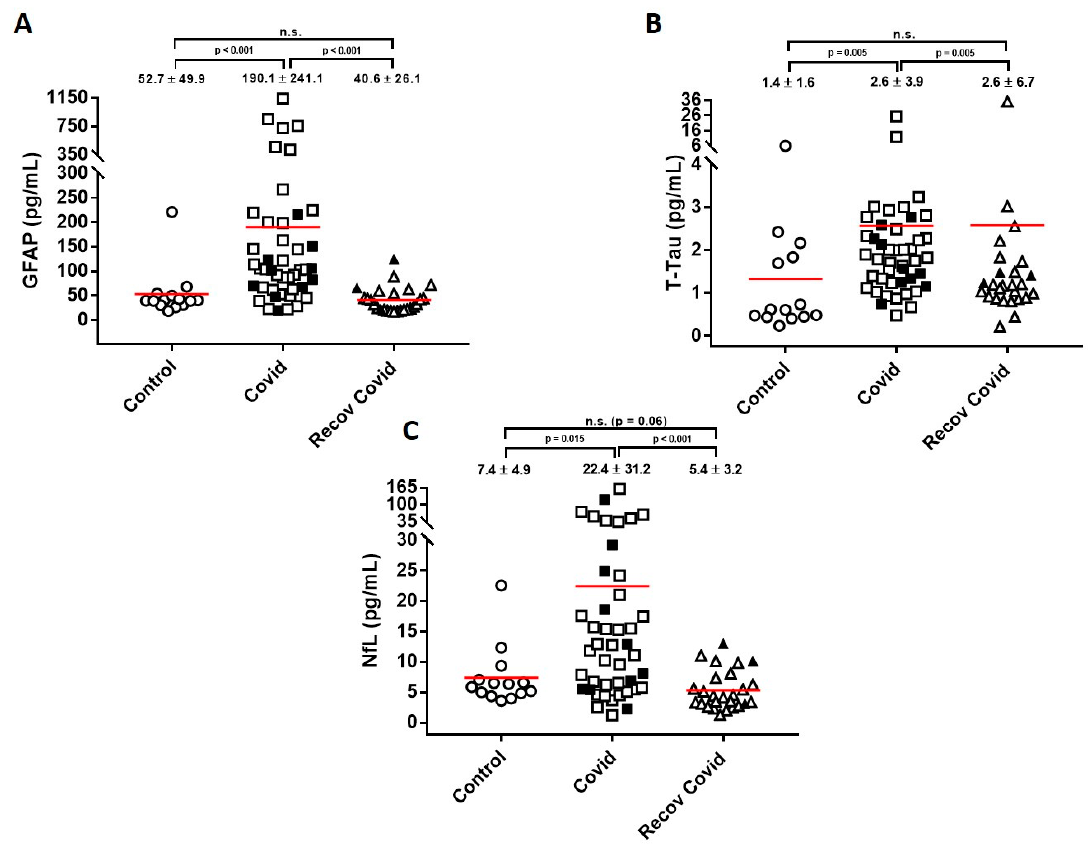
Figure 1. Quantification of astrocytic and neuronal injury biomarkers in COVID-19 patients. The absolute values obtained in plasma for ( A ) glial fibrillary acidic protein (GFAP), ( B ) total tau (T-tau) and ( C ) neurofilament light (NfL) from controls, COVID-19 patients at acute phase of the disease (Covid) and at recovery period (recov Covid; interval of ~2 month between hospital admission and recovery) are shown. Circles: Controls; squares: Covid; triangles: recov Covid; white symbol: moderate severity; black symbol: severe cases. The values are represented as mean, and indicated as mean ± SD. p values estimated by Mann–Whitney U test are indicated. Note the segmentation of the Y axis in all 3 graphs.